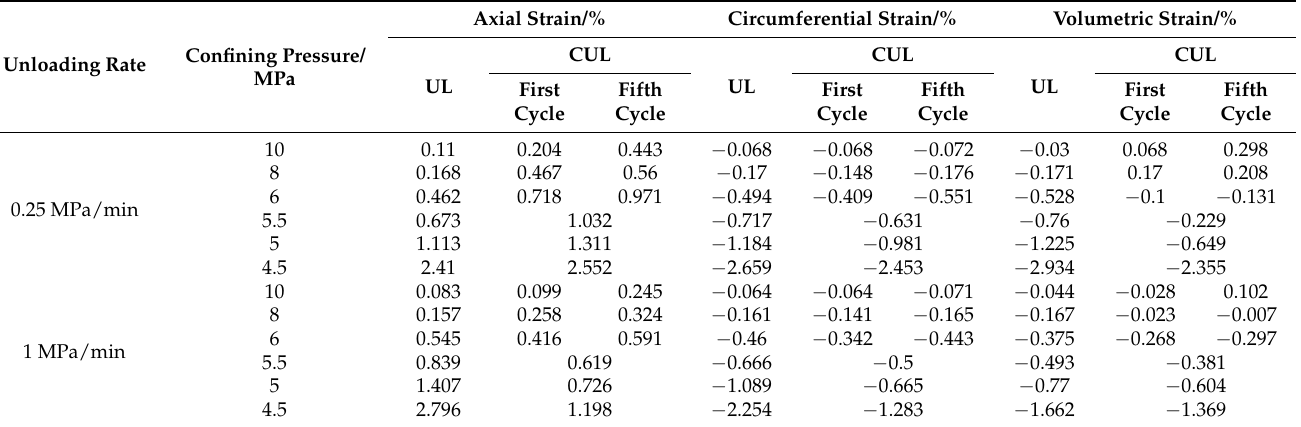
Table 4. Strains under different